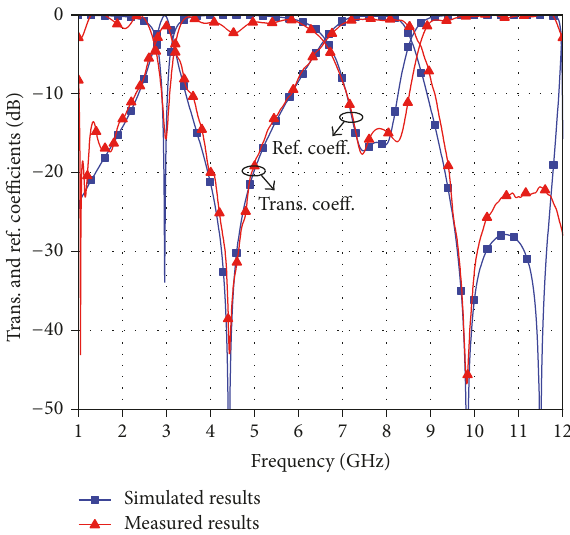
Figure 10: Simulated and measured results of fabricated